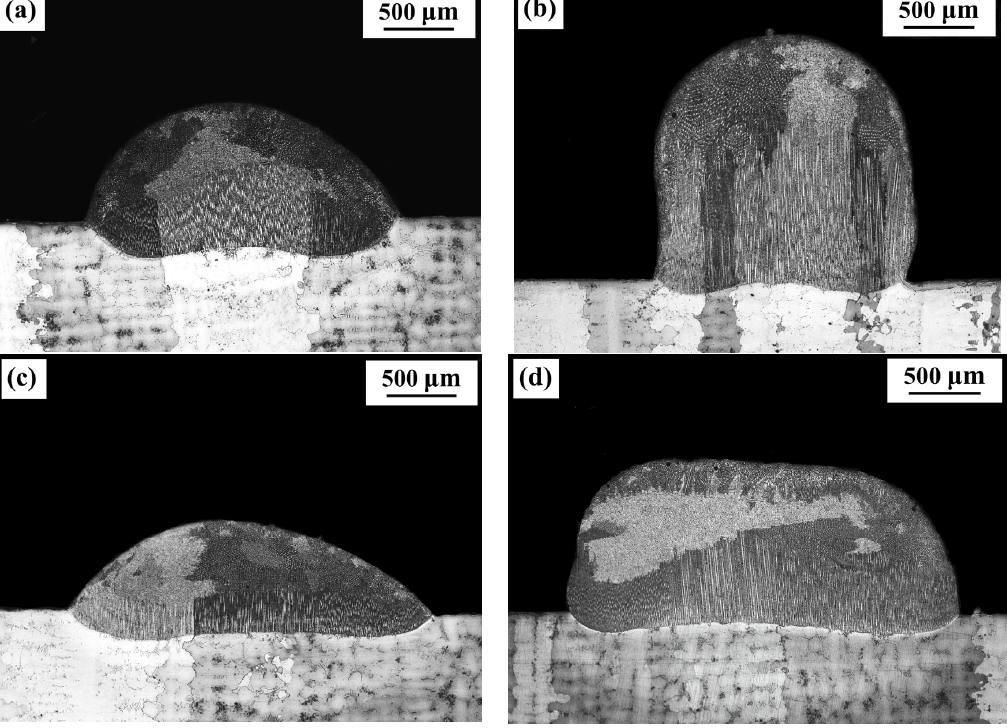
Figure 5. Geometric morphology of the cross-sections of deposits made with four conditions (observed with an OM). ( a ) Circular beam and natural cooling (CN); ( b ) Circular beam and forced cooling (CF); ( c ) Square beam and natural cooling (SN); ( d ) Square beam and forced cooling (SF).